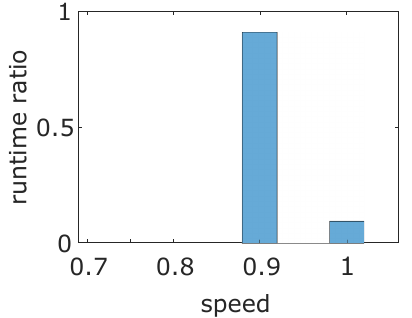
Figure 12. Discrete speed optimization result for the sample water demand of one